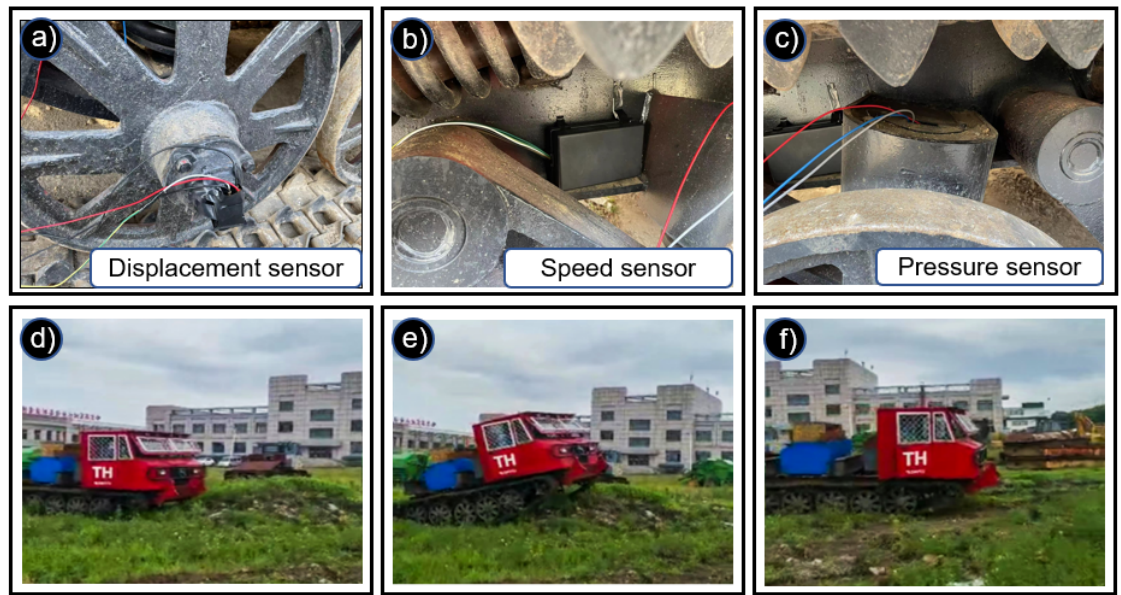
Figure 9. Obstacle climbing test of real vehicle. (Test equipment: ( a – c ); real vehicle test process under tan30° slope: ( d – f )).